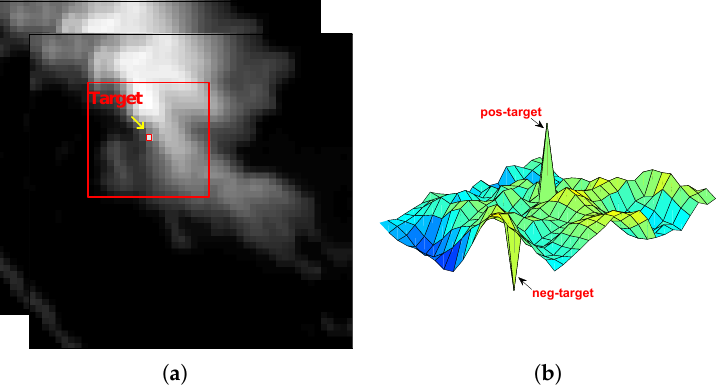
Figure 1. An example of image pair and positive and negative target pairs. ( a ) An image pair with slowly changing cloud clutter. ( b ) Local detection results after image